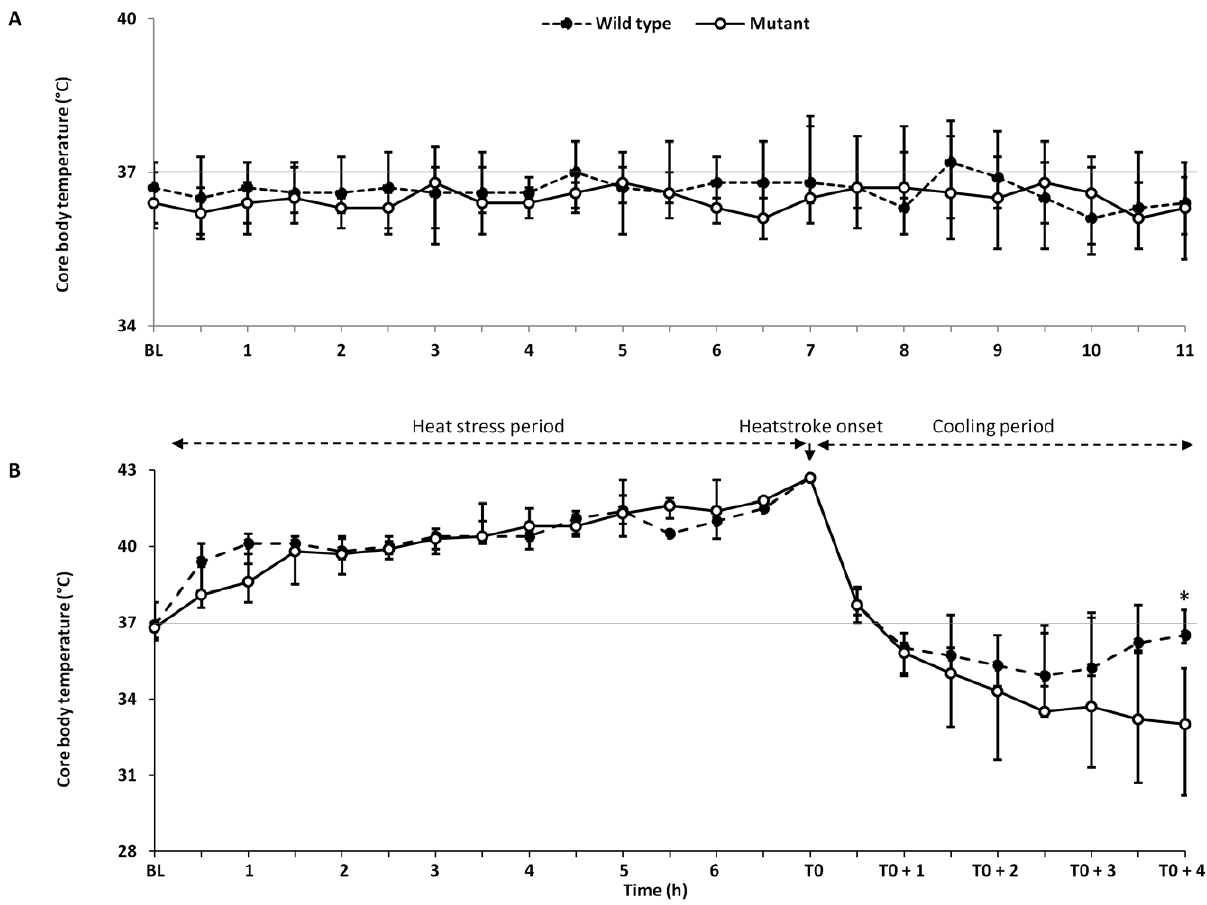
Figure 1. Core body temperature response of mutant and wild mice type to environmental heat stress. Mice implanted intraperitoneally with radiotelemetric transmitters (Data Science International were allowed to recover for 2 weeks after surgery before subjected to heat stress or sham heat stress. ( A ) Core body temperature recorded in mutant and wild type mice at baseline (BL), and during sham heat exposure. ( B ) Core body temperature recorded in mutant and wild type mice at baseline, during cooling and recovery after heatstroke. Values represent median and IQR. *P , 0.05 at T0 + 4 hours between the two groups tested by the generalized estimating equations model.